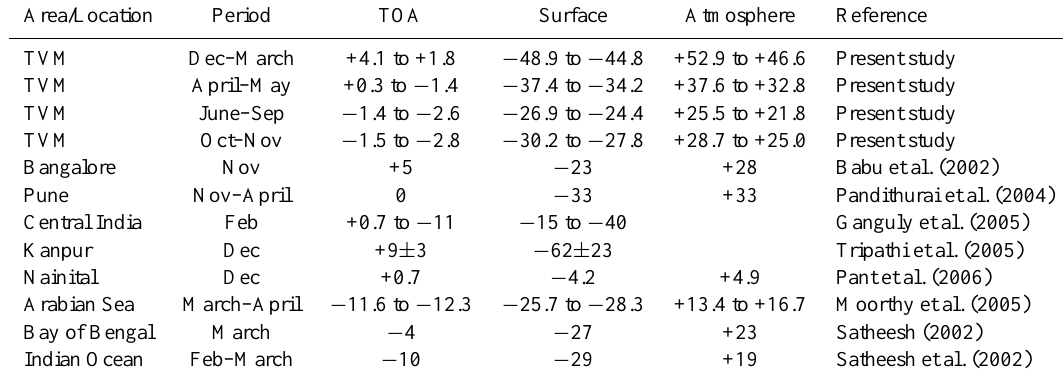
Table 4. Comparison of the radiative forcing (in Wm − 2 ) estimates over TVM with other similar estimates made elsewhere.